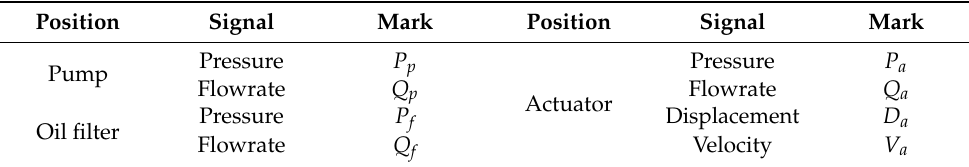
Table 3. Table 3. Collection signals of six Table 3. Collection signals of six states.